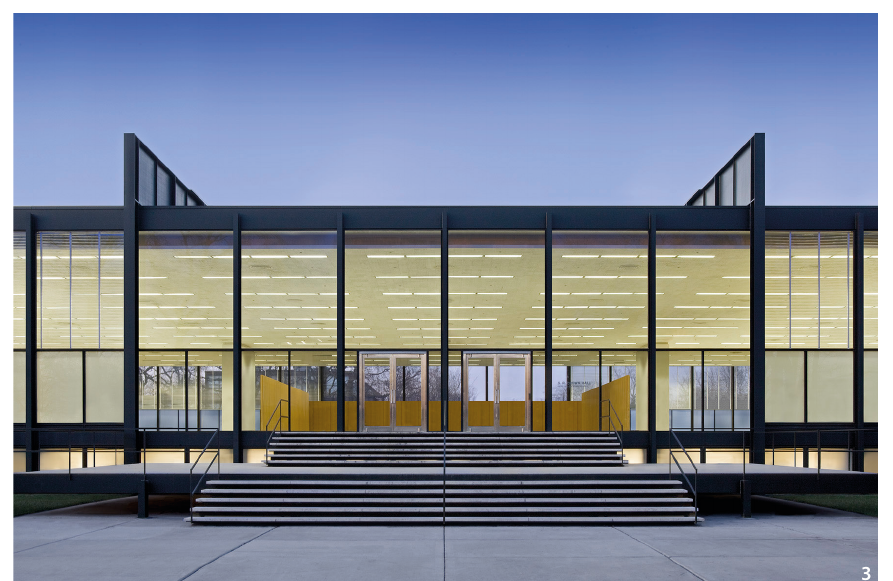
Figure 3 Mies van der Rohe, Crown Hall, Chicago, USA, 1950–1956. Resto- ration by Krueck + Sexton Architects (Source: William